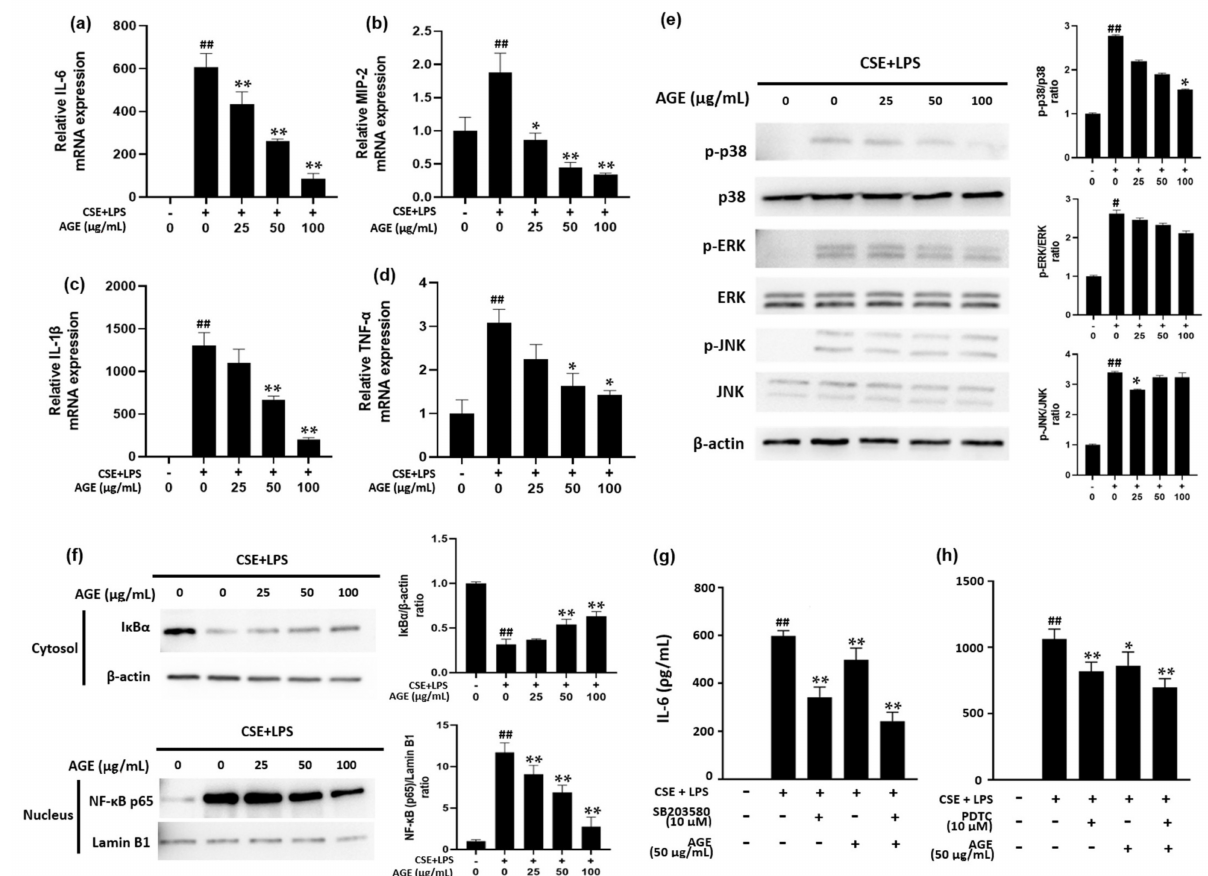
Figure 2. Effect of the Artemisia gmelinii ethanol extract (AGE) on the production of cytokines and chemokines and the activation of MAPK/NF- κ B pathways in MH-S macrophages. First, to measure mRNA levels of IL6 ( a ), MIP2 ( b ), IL1 β ( c ), and TNF α ( d ), MH-S macrophages were pre-treated with 25, 50, 100 µ g/mL of AGE for 2 h and were then treated with CSE (1%)/LPS (10 ng/mL) for 3 h. The mRNA levels were analyzed using quantitative real-time polymerase chain reaction. Secondly, to determine the activation of MAPK ( e )/NF- κ B ( f ) pathways, MH-S macrophages were pre-treated with 25, 50, 100 µ g/mL of AGE for 2 h and were then treated with CSE (1%)/LPS (10 ng/mL) for 15 and 30 min, respectively. Protein expression of p-p38, p38, p-ERK, ERK, p-JNK, JNK, I κ B α , NF- κ B p65, β -actin, and lamin B1 was assessed by Western blotting and data were analyzed using FUSION Solo S software. To measure IL-6, the MH-S cells were pre-incubated with SB203580 (for 1 h) or PDTC (30 min) followed by treatment of CSE (1%)/LPS (10 ng/mL) and AGE for 24 h. The protein levels were analyzed for IL-6 ( g , h ) by ELISA. Data are presented as means ± SD ( n = 3). The significant differences among the groups were analyzed using one-way analysis of variance by Bonferroni’s test (# p < 0.05 and ## p < 0.01 compared to the control group; * p < 0.05 and ** p < 0.01 compared to the CSE + LPS-stimulated